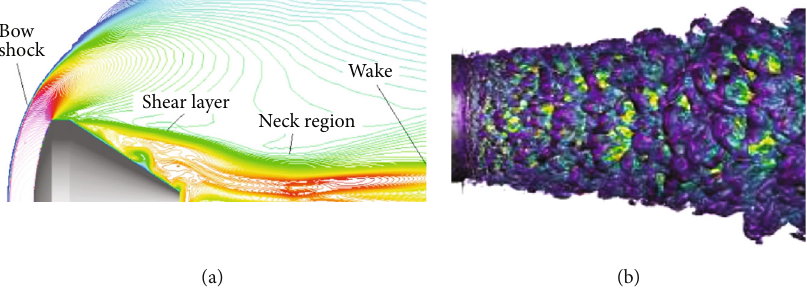
Figure 1: Example applications include (a) reentry capsule aerodynamic heating [3] and (b) heating of fl uid by a turbulent jet fl ow